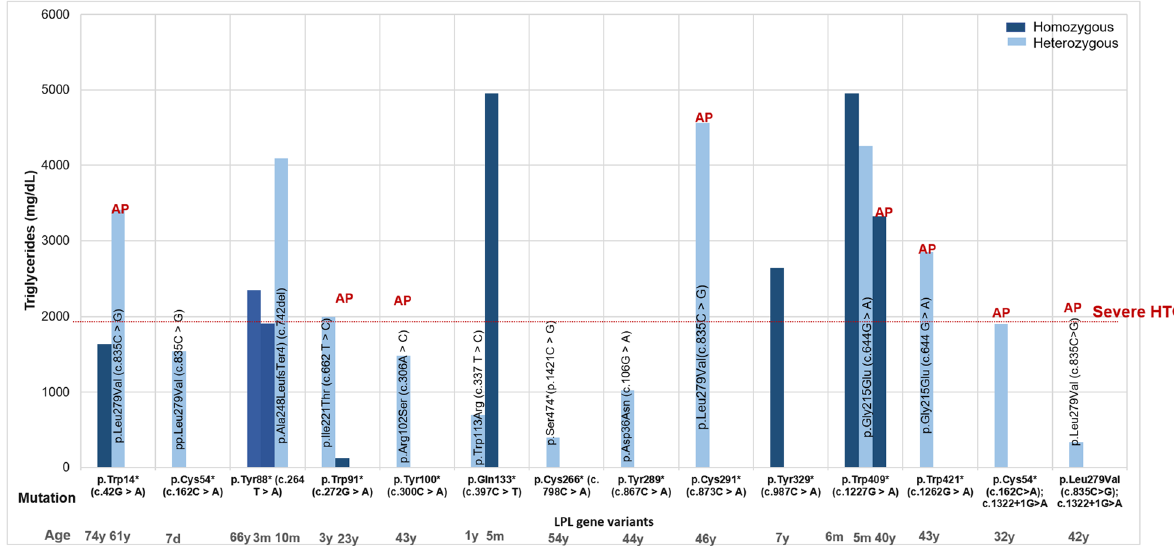
Fig. 7 Pathogenic LPL nonsense variants in published cases. ( AP Acute pancreatitis, HTG Hypertriglyceridemia; number on the bards indicate age d days, m months, LPL lipoprotein lipase, the vertically aligned text indicates the second